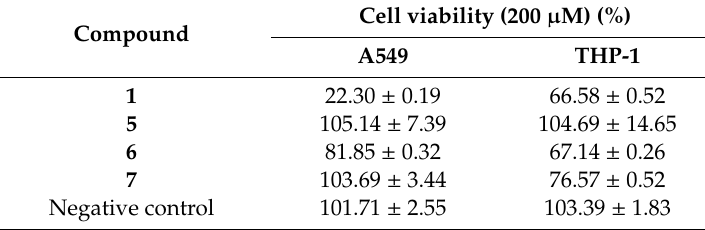
Table 4. The cytotoxicity of the compounds in di ff erent cell